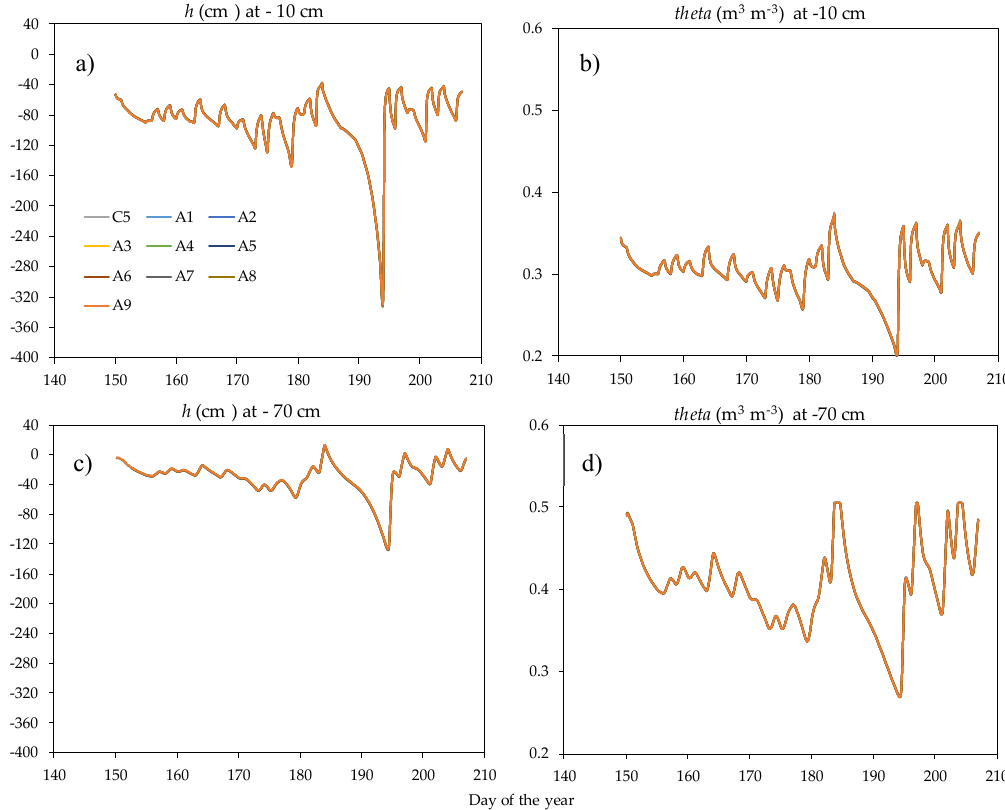
Figure 11. Temporal trend of pressure head ( a , c ) and soil water content ( b , d ) under the nine Ks scenarios.